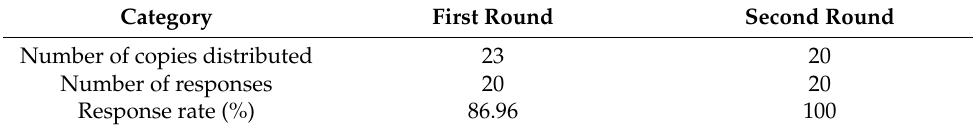
Table 3. Comparison of survey response rates in the two-round modified Delphi